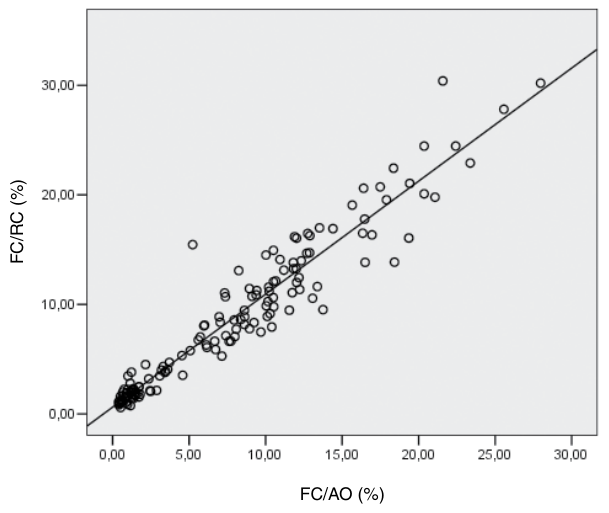
figurE 4 – Reticulocyte count (%) by the automated methods by CF using AO and the kit BD RC ( n = 150). Y: 0.618 + 1.032X; r 2 : 0.923; r: 0.961 FC: flow cytometry; RC: Retic-Count TM ; AO: acridine